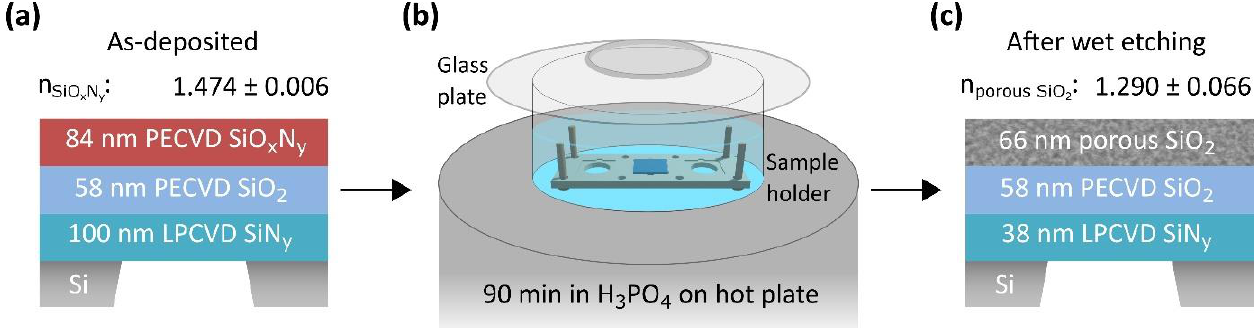
Figure 2. Process transfer of the porSiO 2 synthesis from bulk substrates to free-standing membranes. ( a ) In the first step, a LPCVD SiN y membrane supported by a Si substrate was covered with SiO 2 and subsequently with SiO x N y by PECVD. ( b ) In the second step, the sample was placed on a tailor-made PTFE sample holder in aqueous H 3 PO 4 on a hot plate, which was set to 150 °C, to selectively remove the SiN y compounds from the SiO x N y . A glass plate was loosely assembled on the beaker to avoid concentration changes in the etchant by water evaporation. ( c ) The effective RI of the porSiO 2 was repeatedly reduced to 1.290 by etching of the sample for 90 min. Simultaneously, ultra-thin membranes were generated by thickness reduction of the lowest LPCVD SiN y layer in the H 3 PO 4 . The etchant had access to the membrane’s backside through the hole in the sample holder, which allowed for the SiN y thickness reduction with a rate of (0.65 ± 0.04) nm/min.